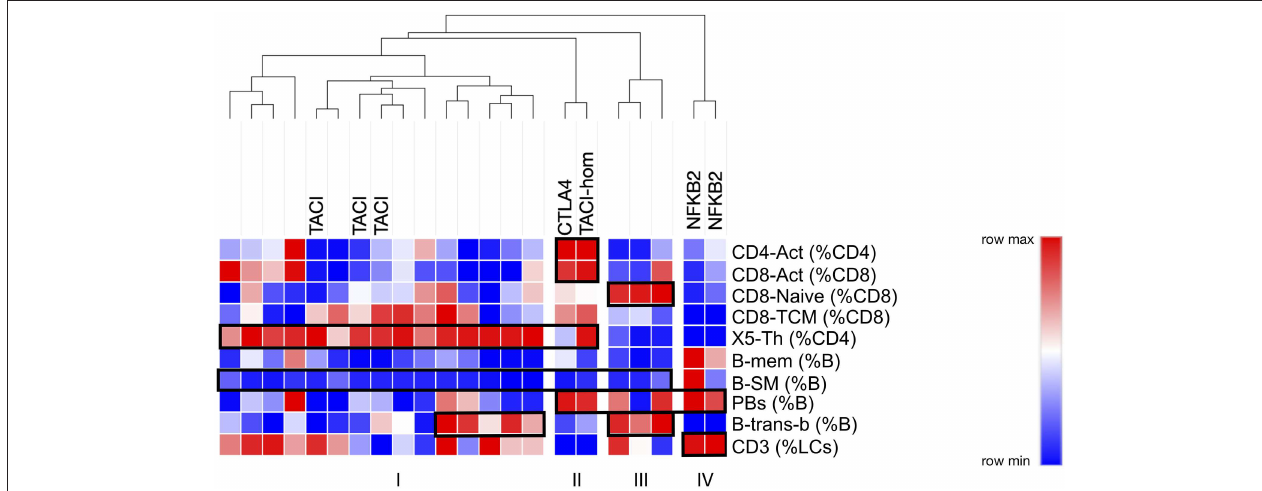
FIGURE 8 | Cluster analysis of PAD patients based on centiles of the top 10 cellular parameters determined as outlined in the legend to Figure 7 (see text). Hereditary branches show relatedness in terms of cellular similarities, the major ones highlighted in boxes. Known genotypes are shown.